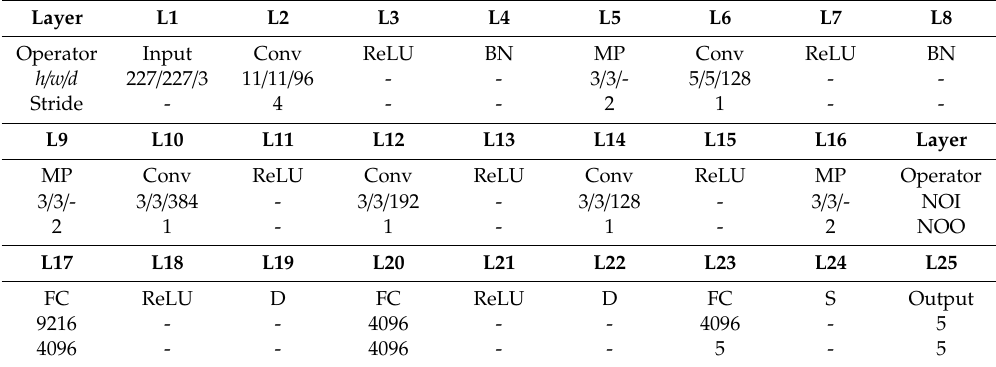
Table 3. Specific structure of the CTI network (BN is batch normalization layer; the meanings of the other abbreviations are consistent with those in Table 2).